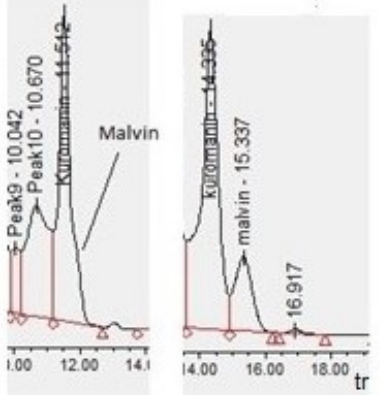
Figure 6. HPLC-DAD chromatographic separation of malvin and kuromanin ( left : conventional Flamini and Favretto method; right : modified Flamini and Favretto method).